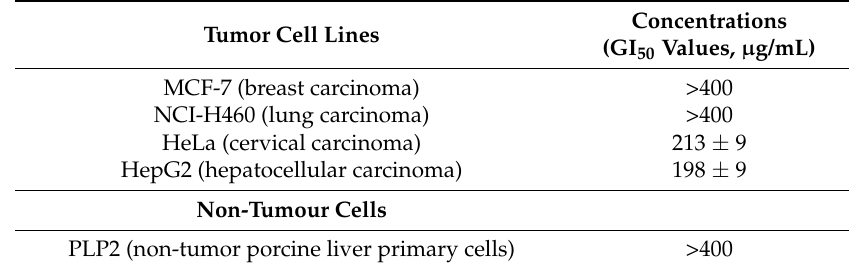
Table 8. Cytotoxic activity of the anthocyanins rich extract obtained under optimal extraction conditions (mean ±